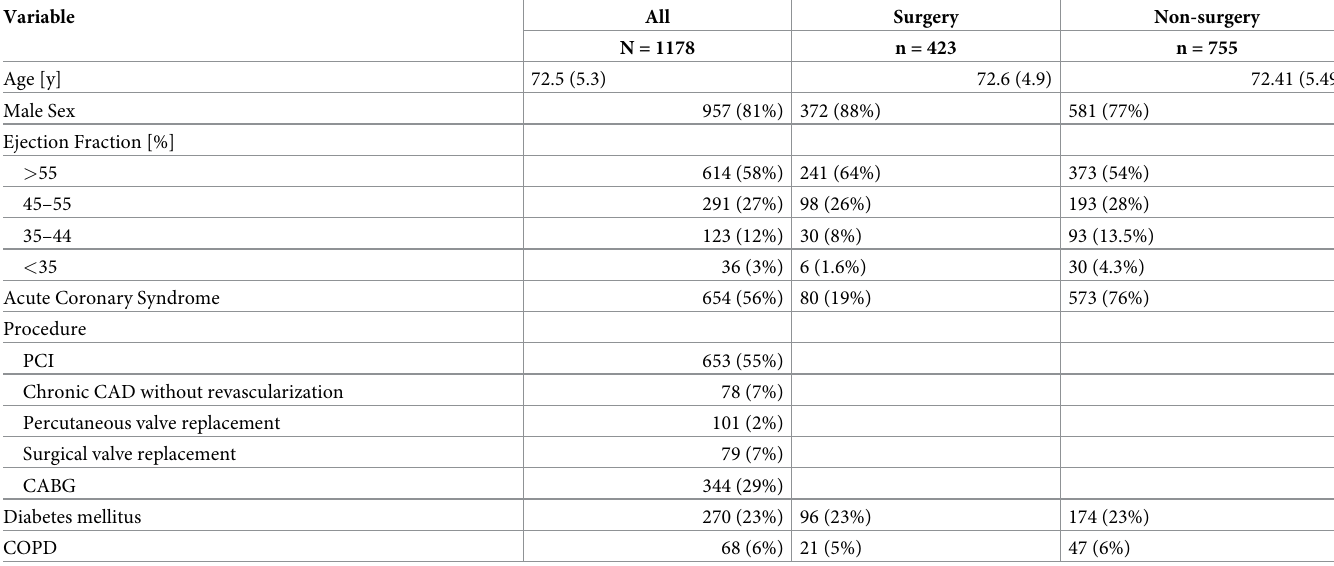
Table 1. Baseline characteristics.